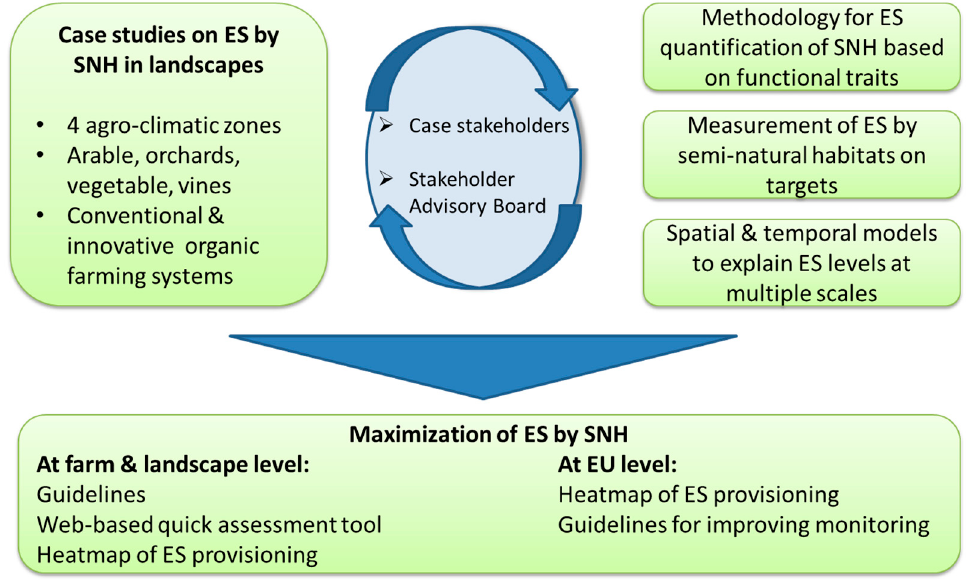
Figure 3. Conceptual scheme of QuESSA (Quantification of Ecological Services for Sustainable Agriculture) project approach (ES = Ecosystem Services; SNH = Seminatural Habitats).